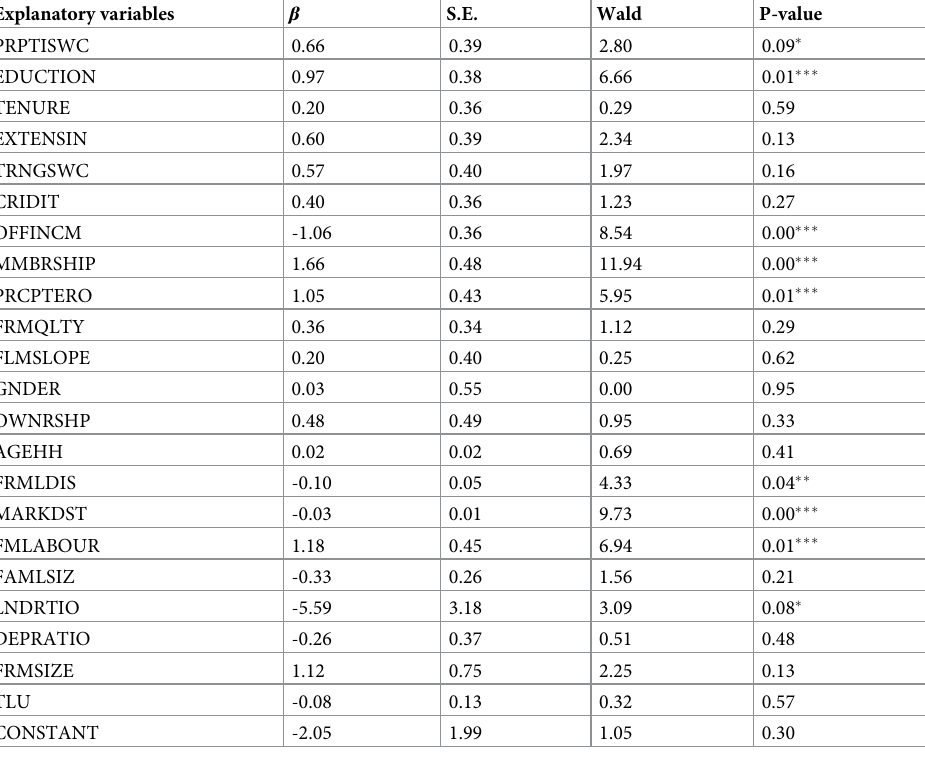
Table 4. Binary logistic regression model estimates for adoption of SWC practices in Lege- lafto watershed. Explanatory variables β S.E. Wald P-value PRPTISWC 0.66